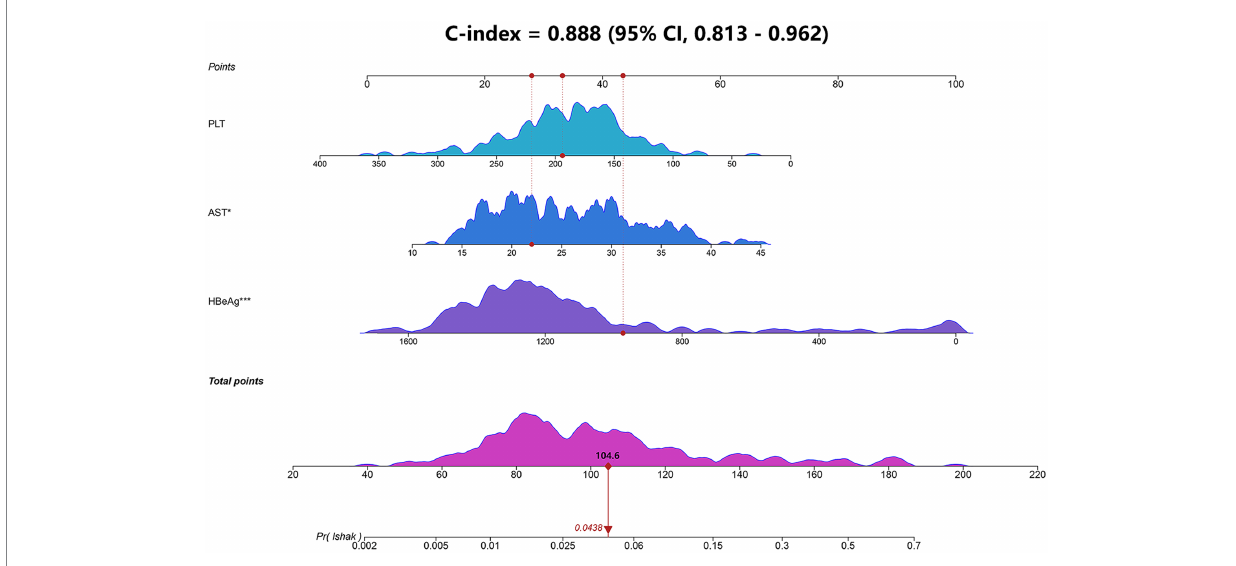
FIGURE 2 Nomogram (IT-3) for predicting liver fibrosis in IT-phase patients. The IT-3 model was developed using the training cohort and discrimination was evaluated by concordance index (Cindex). AST, aspartate transaminase; HBeAg, hepatitis B e-antigen; PLT, platelet.